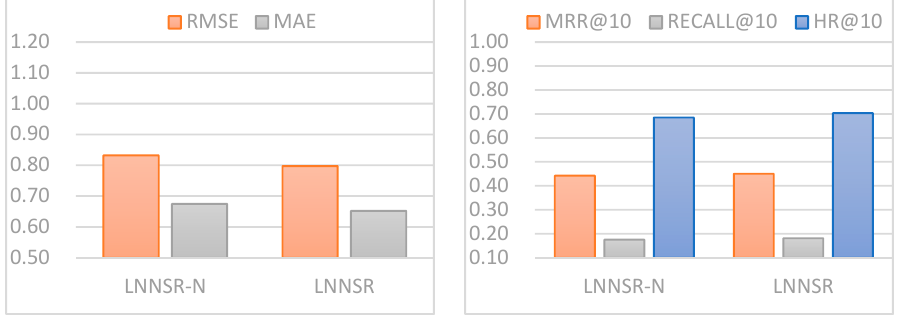
Figure 7. Effect of granularity distribution proportion weights of node’s attributes on MovieLens-1M dataset.